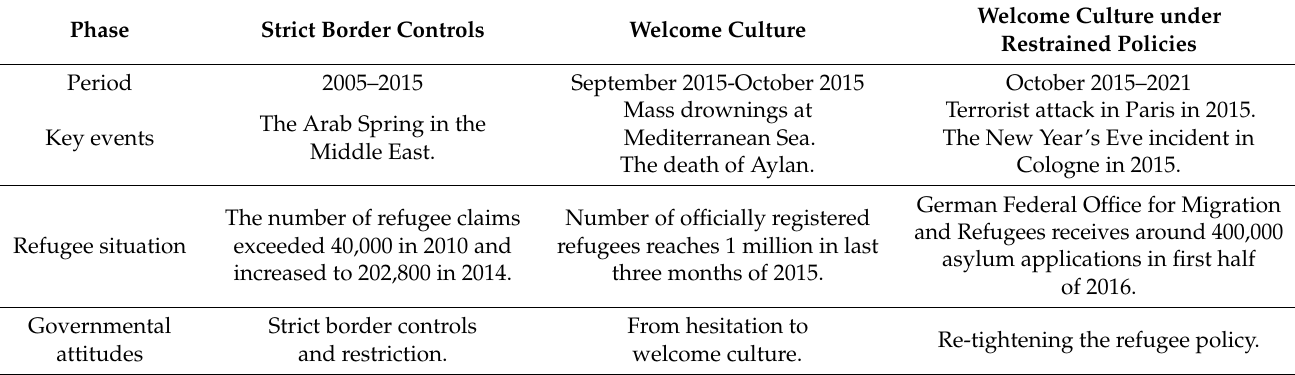
Table 1. Refugee Policy Evolution in Germany, table made by